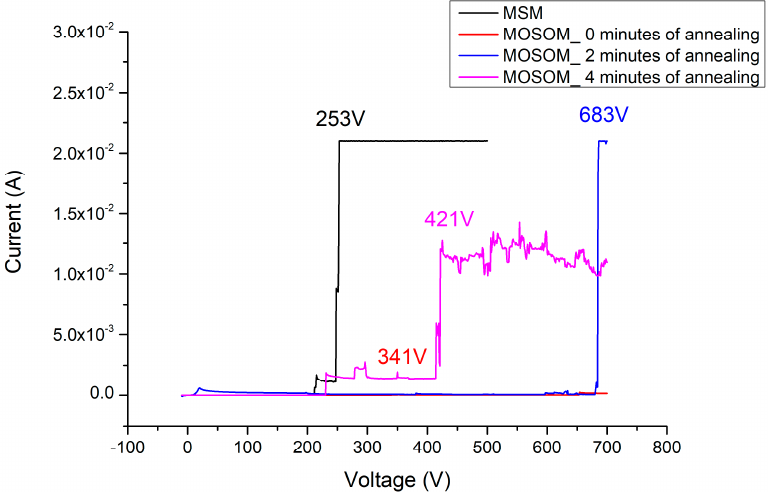
Figure 24. I–V measurement results of the MOSOM varactors under different annealing parameters.